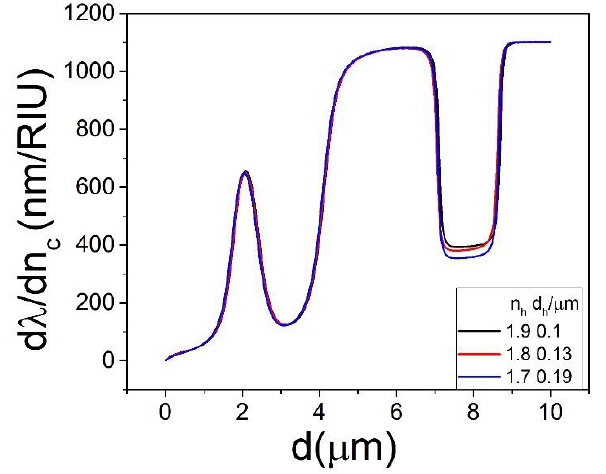
Figure 9. The dependence of ∂λ / ∂ n c on d for the p = 2 mode for n c = 1.4 and D = 150 µ m calculated for select values of d h and n h .